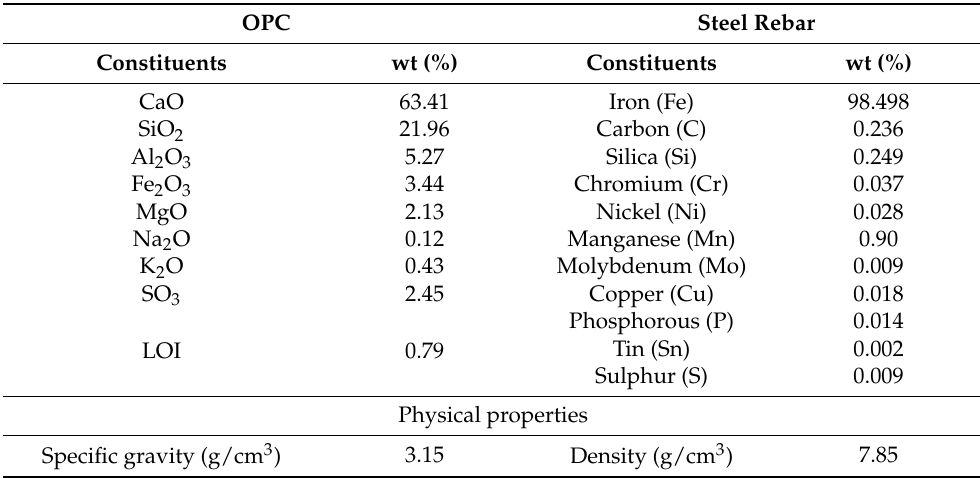
Table 1. Chemical composition of ordinary Portland cement (OPC) and Thermomechanical treated (TMT) steel